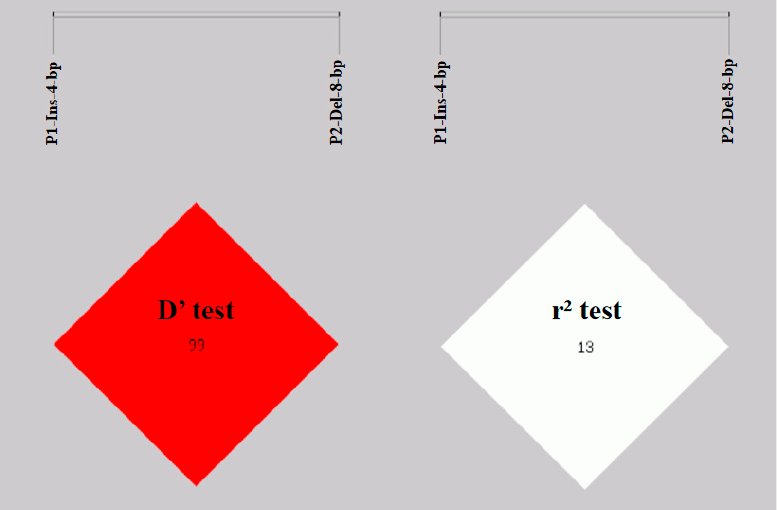
Figure 8. Linkage equilibrium analysis of P1-Ins-4-bp and P2-Del-8-bp in the SDBCGR